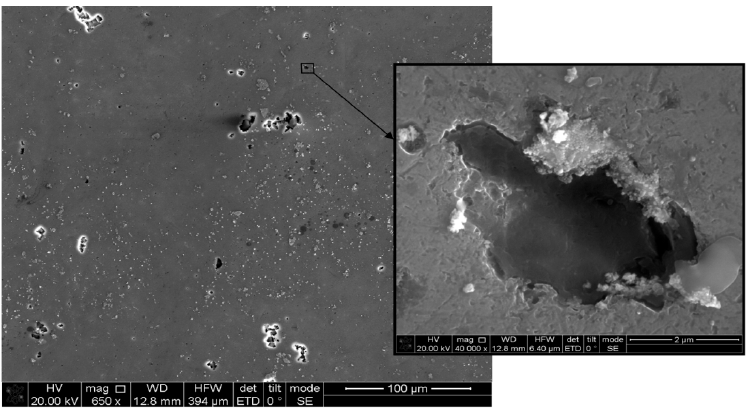
Figure 5. Formation of localized blisters on the surface of 5083 Al alloy after hydrogen charging at 30 mA/cm 2 for 6 h.